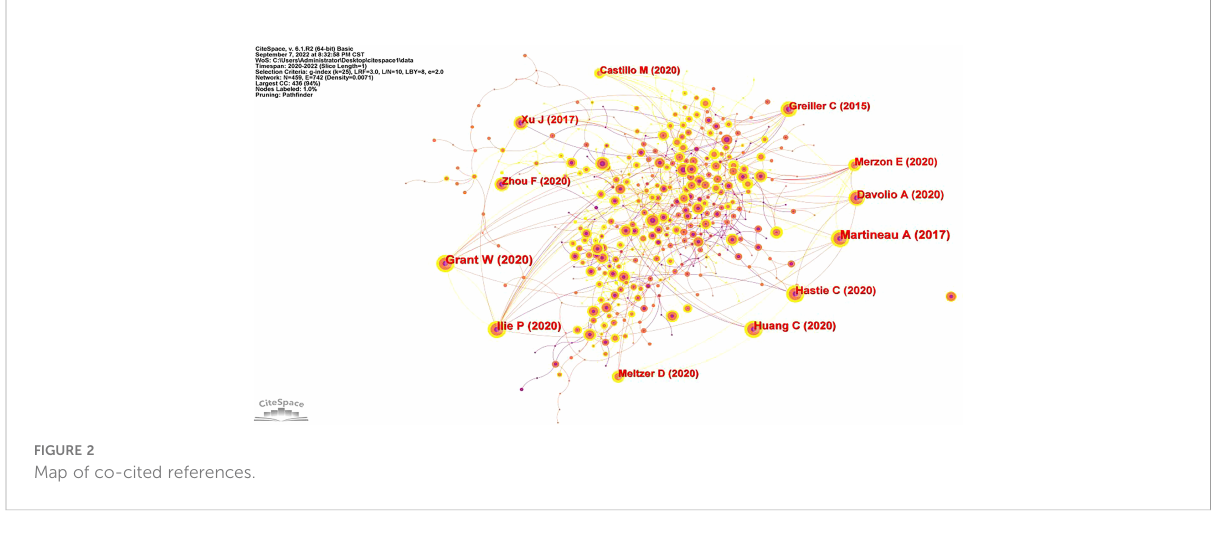
FIGURE 2 Map of co-cited references.